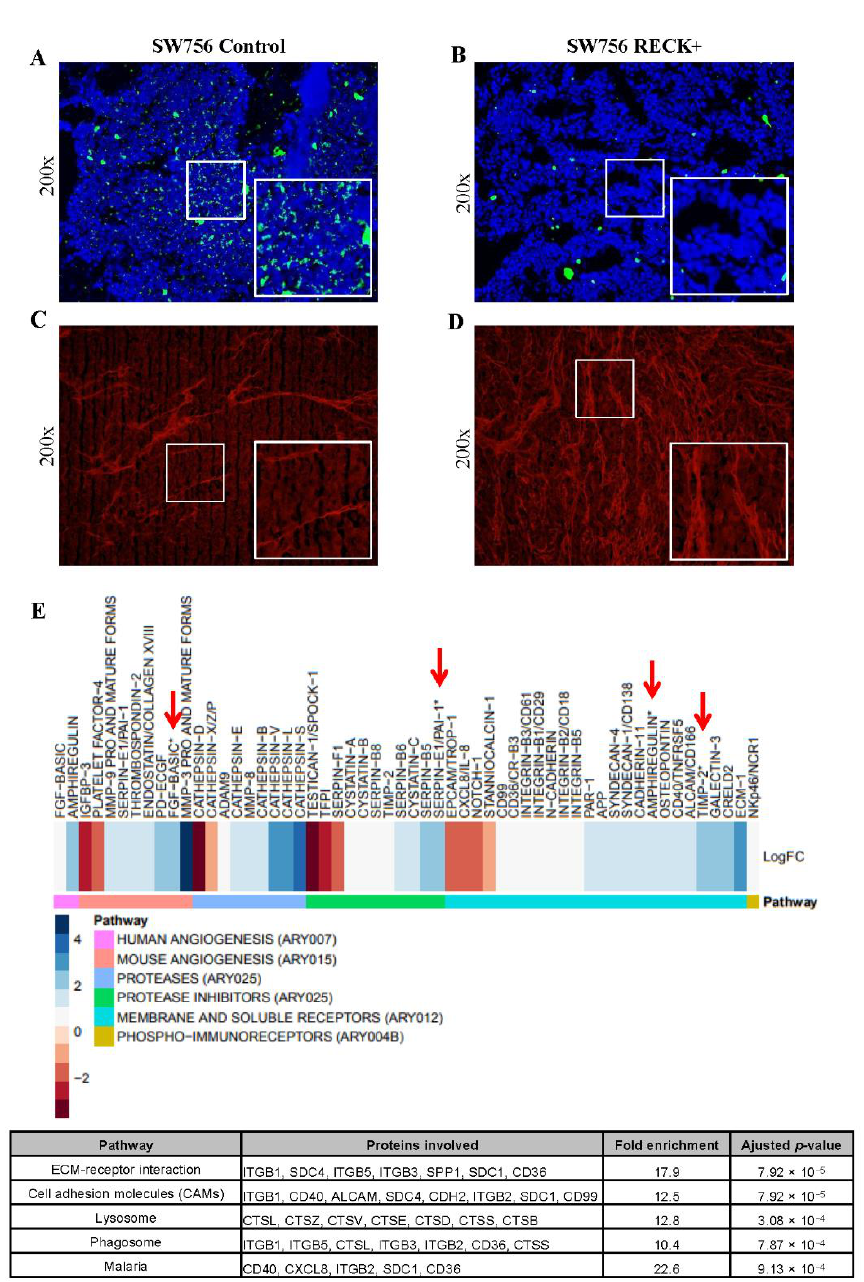
Figure 5. SW756 RECK+ tumors present collagenase activity, higher collagen content and increased levels of collagenase inhibitors. ( A , B ). In situ zymography assay carried out with SW756 tumors using DQ Collagen IV (green signal represents collagen breakdown). ( C , D ) Representative images showing Picro Sirius fluorescent staining of SW756 tumors (red signal shows collagen fibers). All fluorescent assays were carried out in the presence of DAPI staining and the merged images were processed using Image J software. ( E ). Heatmap representation of differentially expressed proteins in RECK+ tumors when compared to control. The fold change is expressed in log 2 scale; where blue and red scale represents increased and decreased relative expression, respectively. Antibody arrays were depicted in different colors on the far-left side, below the heatmap. Proteins were identified as differentially expressed when fold change, expressed in log 2 , was over 0.58 or under − 0.58. Red arrows show differentially expressed proteins detected in more than one antibody array. The table displays the enrichment analysis in KEGG pathway database with use of DAVID web tool. Statistical analysis was performed with Fisher’s exact test